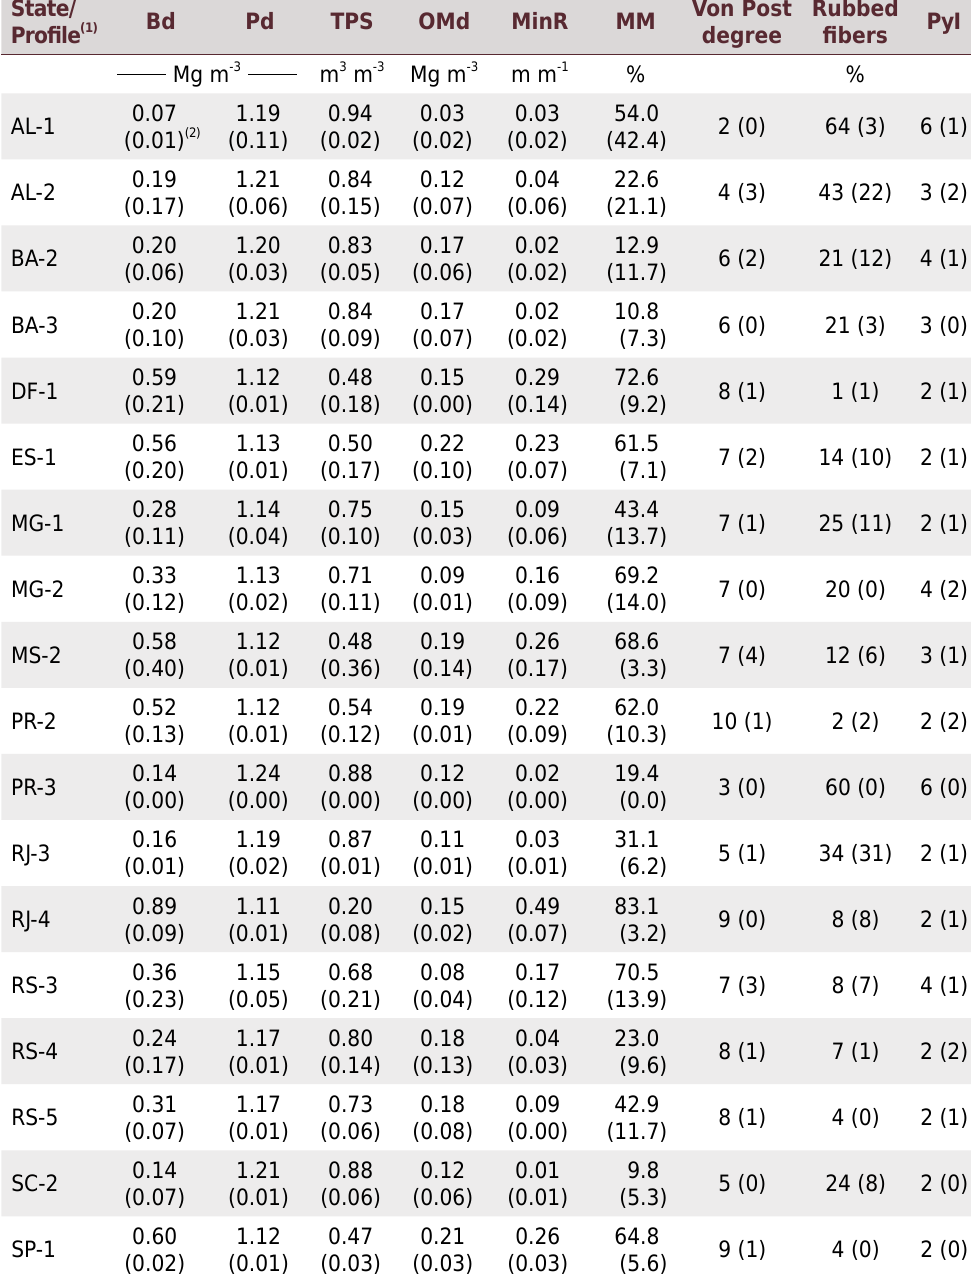
Table 3. Physical properties (bulk density - Bd, particle density - Pd, total pore space - TPS, organic matter density - OMd, minimum residue - MinR, mineral matter - MM) and degree of organic matter